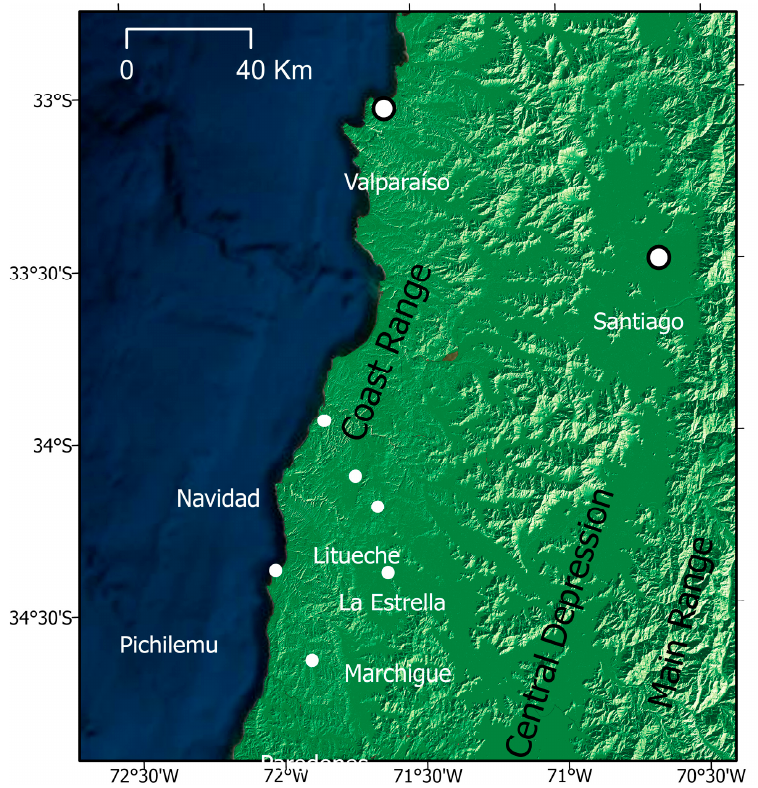
Figure 2. Study area and location of urban areas: Navidad, Litueche, La Estrella, Marchigue, Paredones, and Pichilemu; Coast Range, Central Depression, and Main Range. Background DTM ALOS 30 mts.